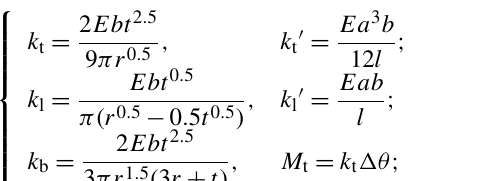
Figure 4. Simplified principle diagram of mechanism.